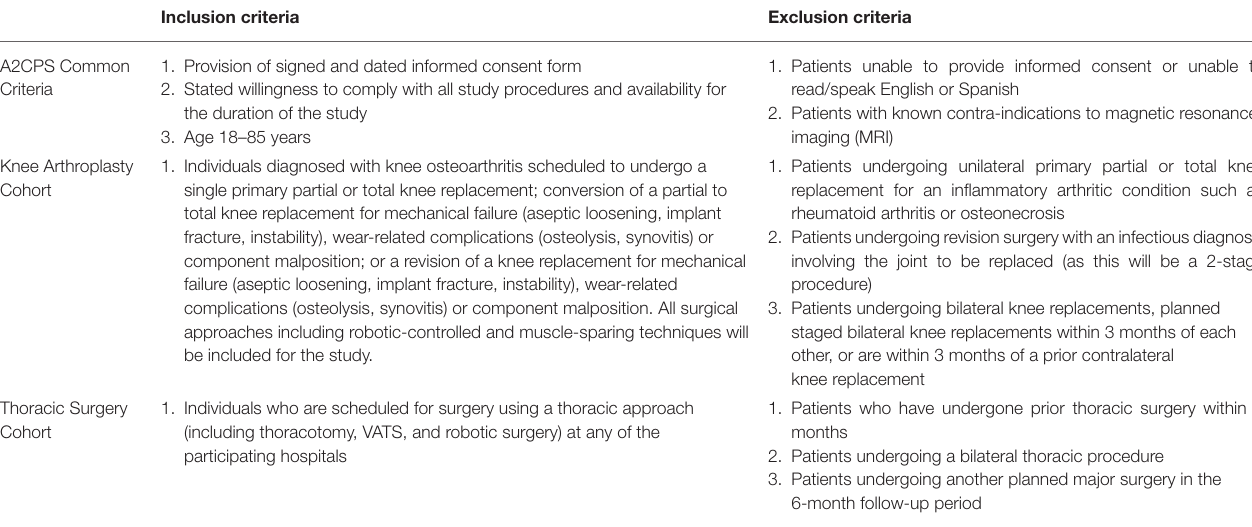
TABLE 1 | A2CPS eligibility